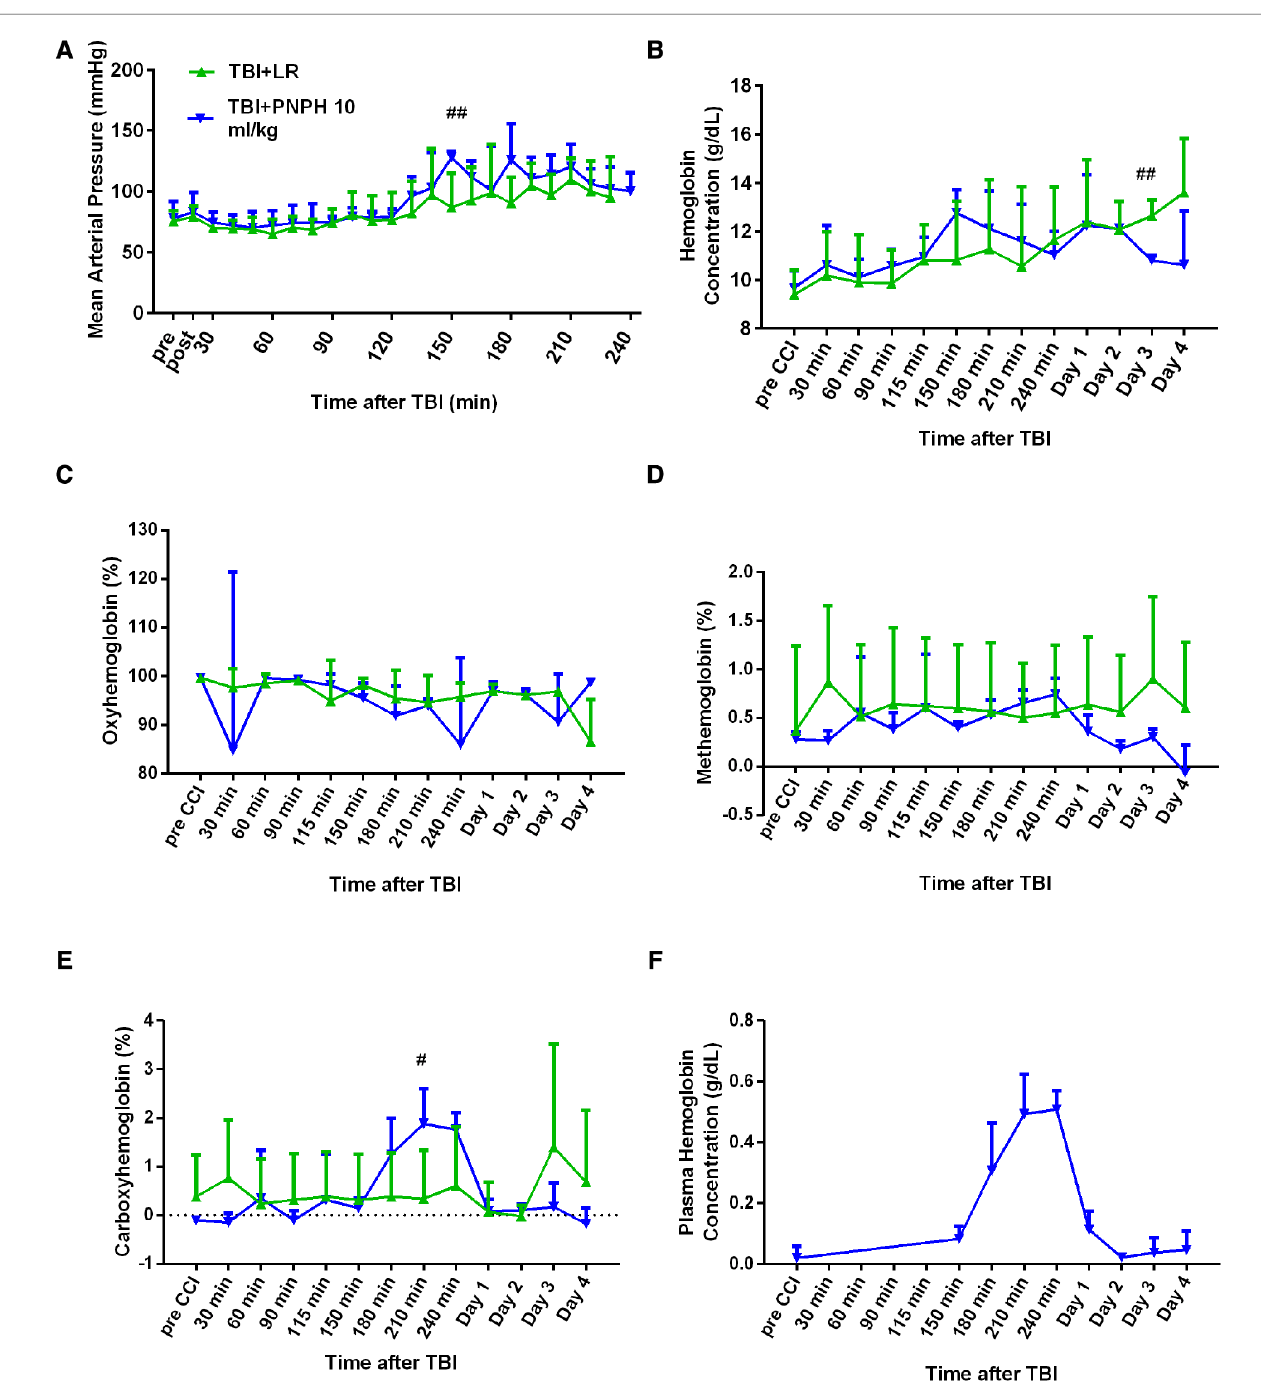
FIGURE 7 Systemic physiologic changes after TBI without hemorrhagic shock. Mean arterial pressure ( A ), hemoglobin concentration ( B ), percent of oxygenated hemoglobin ( C ), percent of methemoglobin ( D ), and percent of carboxyhemoglobin ( E ) in whole blood for pigs subjected to TBI followed by infusion of 10 ml/kg of lactated Ringer ’ s (LR) solution or PNPH at 120 – 180 after TBI. Sample sizes per time point were 4 – 6 for LR group and 5 – 6 for 10 ml/kg PNPH group (smaller sample sizes occurred at 180 – 240 min when arterial blood samples could no longer be drawn because the pig was too active or the subcutaneously-routed catheter was inoperable). Individual data are shown in Supplemental Figures 6 – 10 . PNPH infusion produced an increase in plasma hemoglobin concentration ( F ). Values are means±SD. # P <0.05, ## P <0.01 LR infusion vs. PNPH infusion group determined by one-way